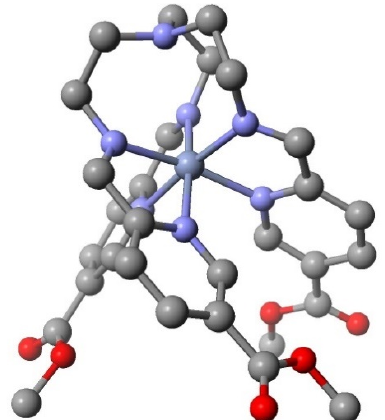
Figure 4. Structure of a tripodal SB chromium(II) complex. The hydrogen atoms have been removed for clarity. The structural parameters, Cr-N imine , Cr-N pyridine , Cr-N ap , N imine –Cr-N pyridine , and C-N ap –C, for the Cr(II) and Cr(III) complexes are as follows, Cr(II) 1.989 Å, 2.027 Å, 3.086 Å, 79.040°, and